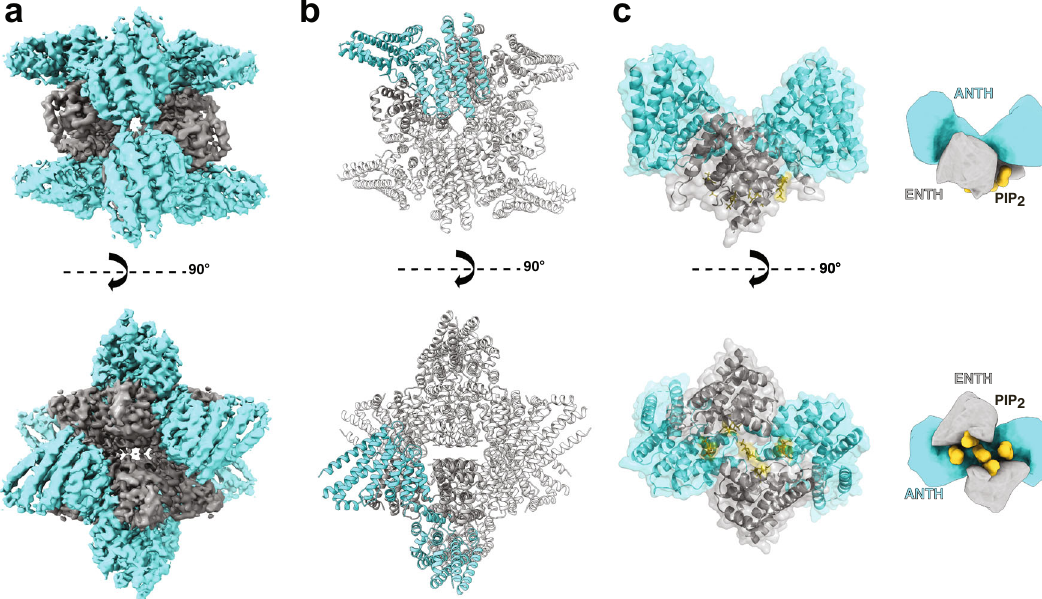
Fig. 1 Cryo-EM structure of a 16-mer AENTH complex. a Cryo-EM reconstruction obtained for the 16-mer complex formed by 8 ANTH and 8 ENTH units (A 8 E 8 ). The density corresponding to ANTH and ENTH is colored correspondingly in cyan and gray. b Model of the A 8 E 8 complex built based on the EM density shown in cartoon representation. One tetramer is colored with the ANTH domains in cyan and ENTH domains in gray (see Supplementary Fig. 4 for symmetry axes). c The building unit is the AENTH tetramer (A 2 E 2 ) shown in cartoon and surface representation, with the ENTH domains in gray and the ANTH domains in cyan. The PIP 2 polar heads bound to the tetramer are shown in stick representation (gold). A schematic of the tetramer is shown next to the